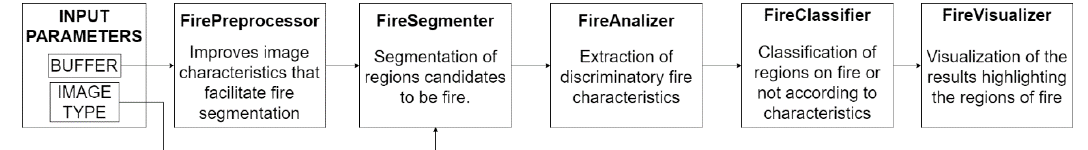
Figure 2. General block diagram of the fire detection system